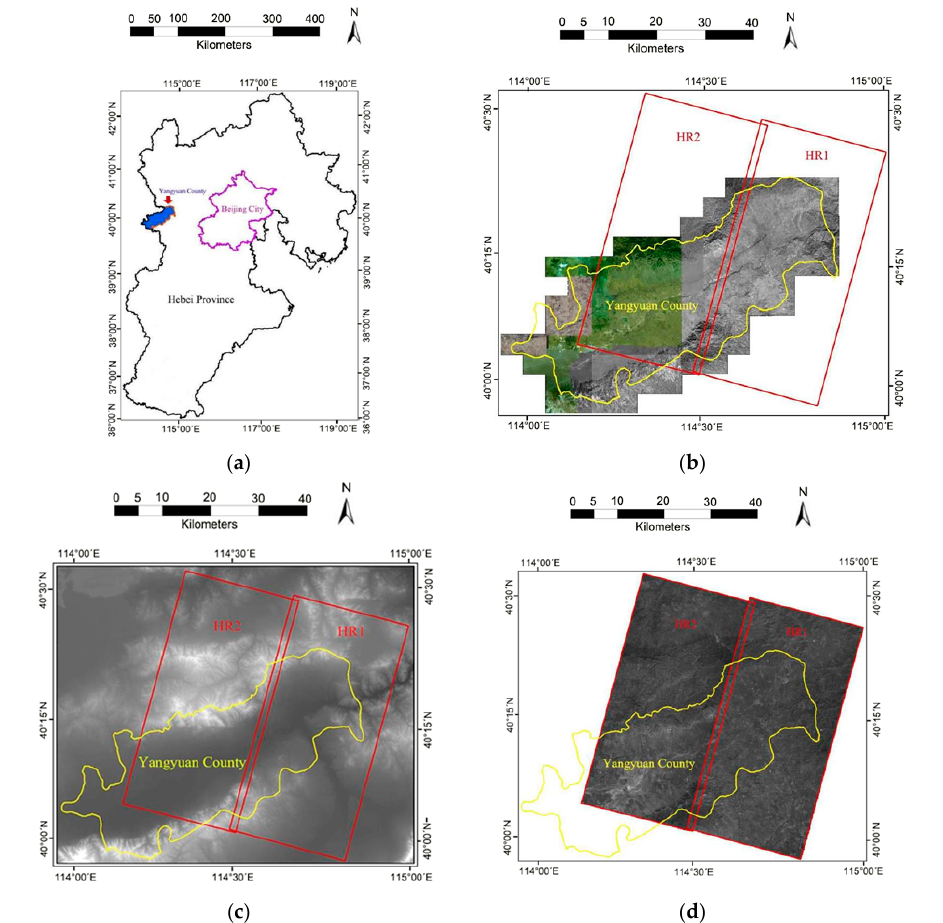
Figure 1. The location of the experimental area and presentation of experimentally used image data: ( a ) the location of the experimental area; ( b ) base image; ( c ) DEM data; and ( d ) warp images: HR1/HR2.